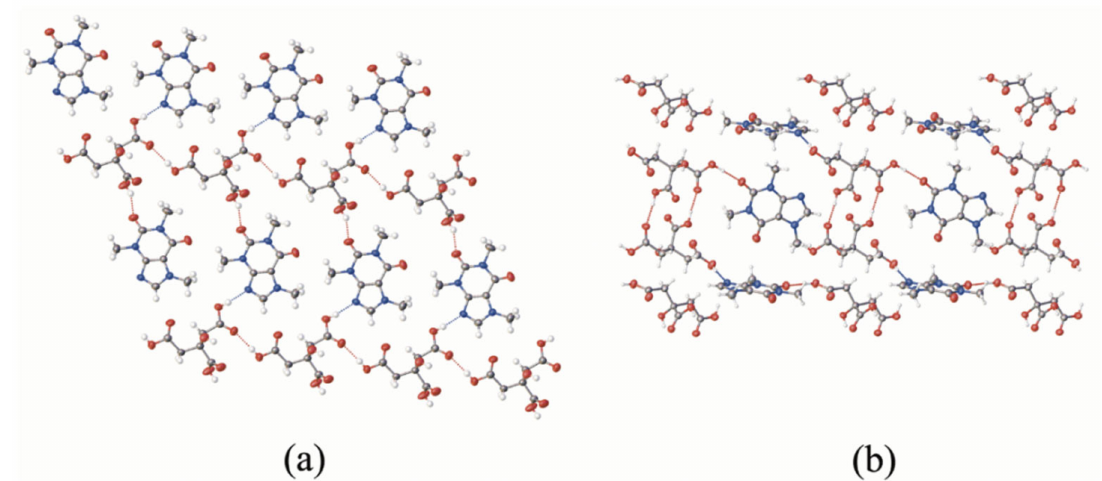
Figure 6. Sheets of caf:ca (1:1) ribbons. ( a ) Form I and ( b ) Form II. CSD refcodes: Form I; KIGKER (P¯ı) [216] and Form II; KIGKER01 ( P 2 1 / c ).